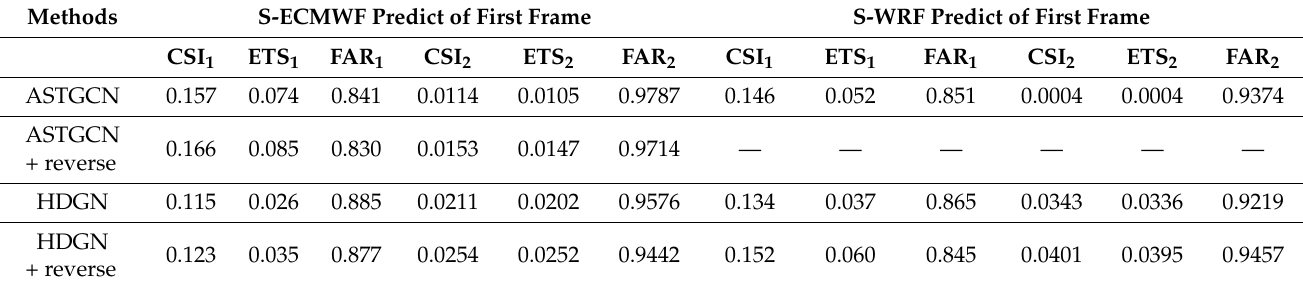
Table 6. Data processing to demonstrate the effectiveness of reversed sequence enhancement. The improvement with the S-ECMWF dataset was more significant than that with the S-WRF dataset. The symbol ‘—’ indicates that the model did not function owing to excessive number of